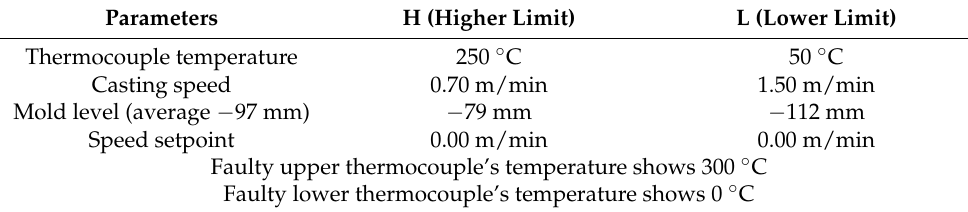
Table 5. Basic parameters list of the